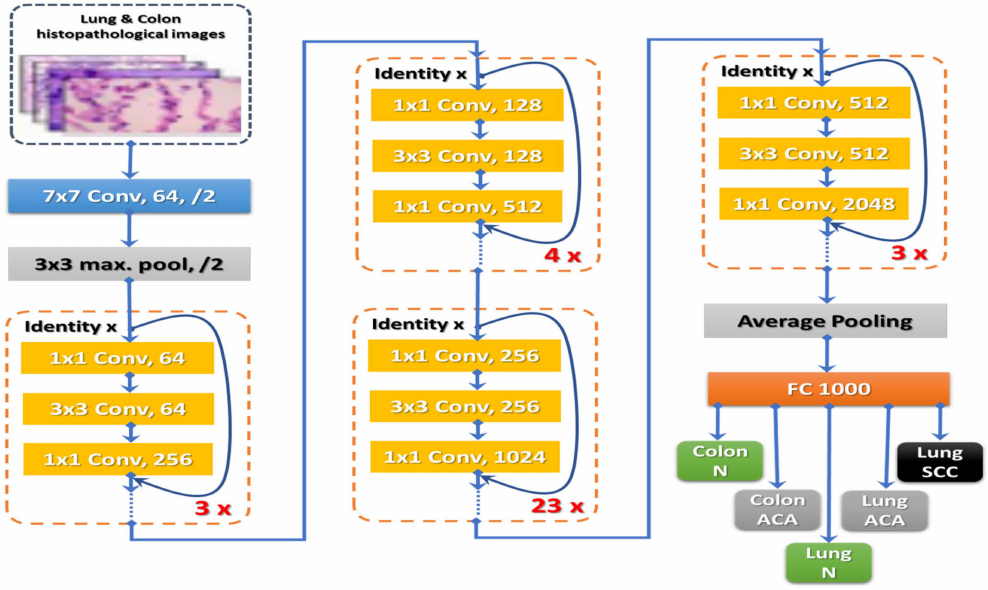
Figure 3. ResNet101’s architectural